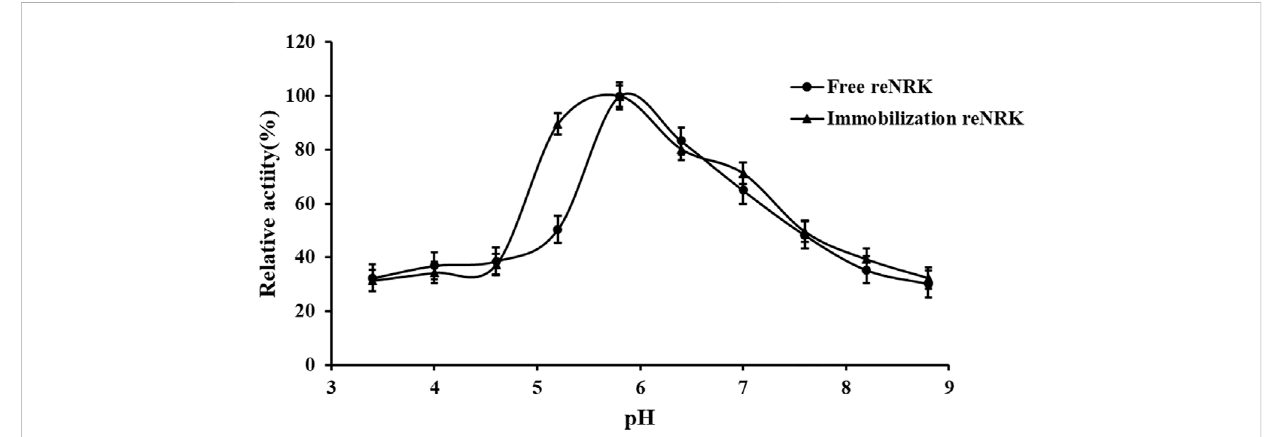
FIGURE 7 ThepHoptimumofthere Sc NRK1.ThepHoptimumoftherre Sc NRK1wasassayedbythestandardactivityassaymethodasstatedaboveexceptthe reaction pH values ranging from 3.4 to